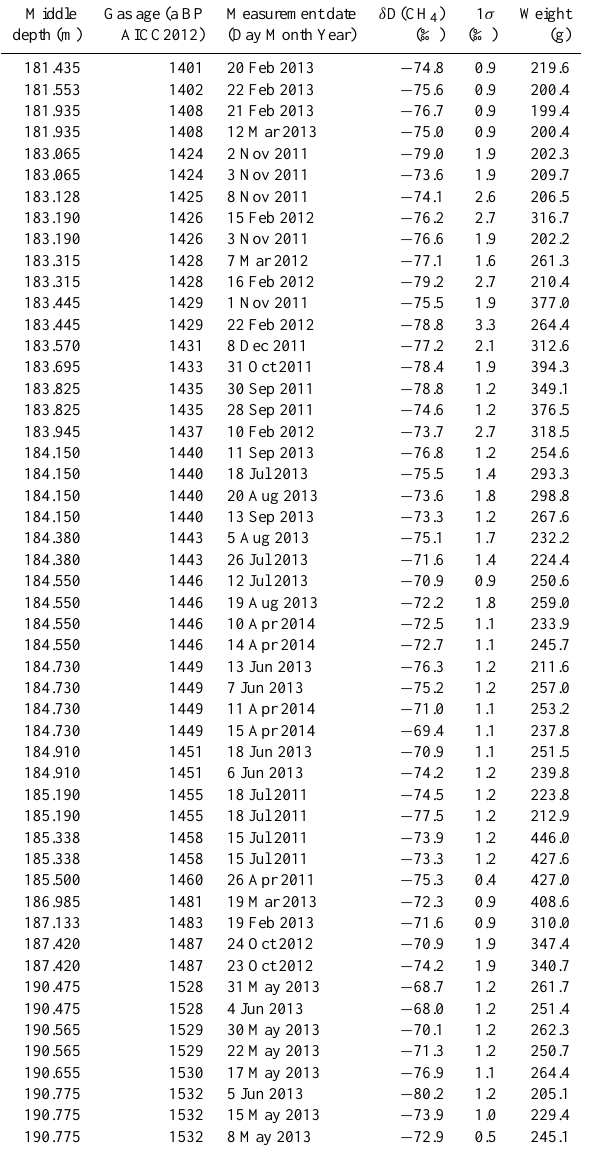
Table 4. Results of ice core samples from B34. Given depth indi- cates the middle of each sample. Depending on replicate shape and weight, typical samples are between 5 and 15cm long. Gas ages are estimated from the official AICC2012 chronology (Veres et al., 2013) for the EDML core, which is located nearby. The standard de- viation of Air Controlé measurements used to calibrate the sample is given in the column named 1 σ . Samples with a weight < 220g correspond to a methane amount comparable to samples from the glacial with lowest CH 4 concentration of around